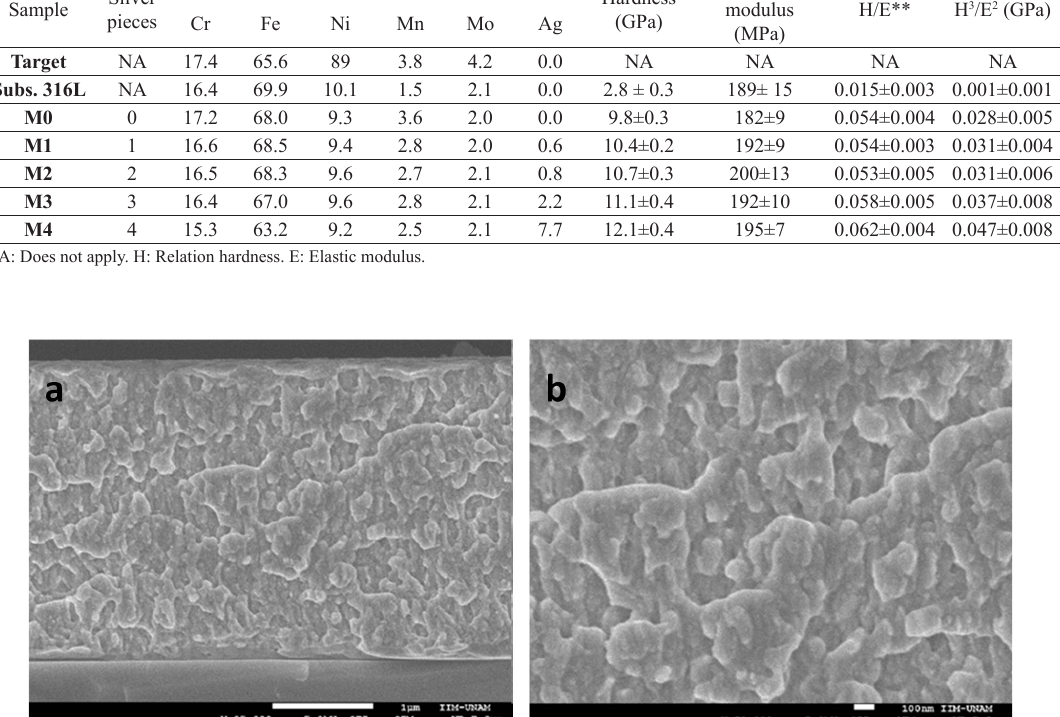
Table 2. Chemical composition, hardness, and elastic modulus of coatings. Sample